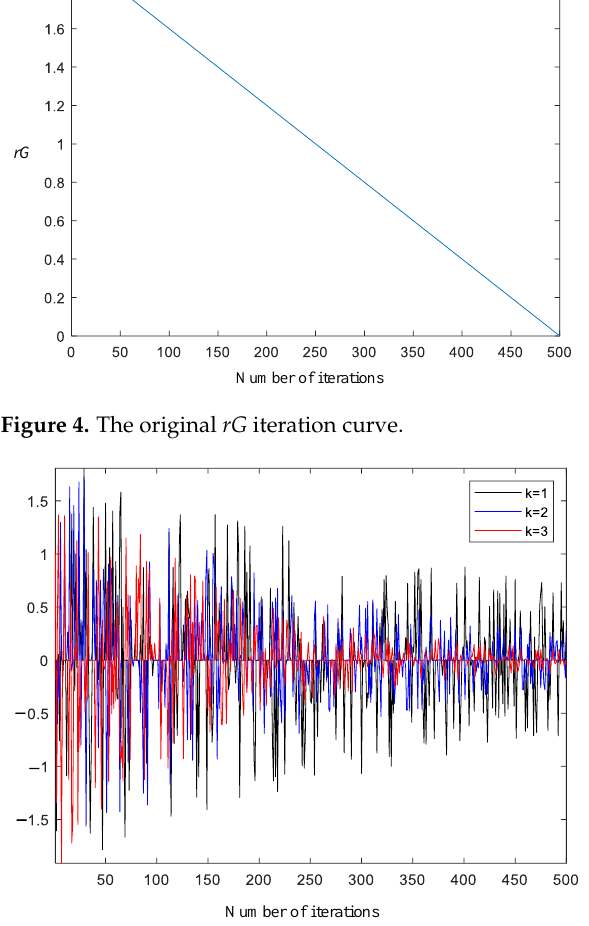
Figure 5. Water wave dynamic factors for different values of k .